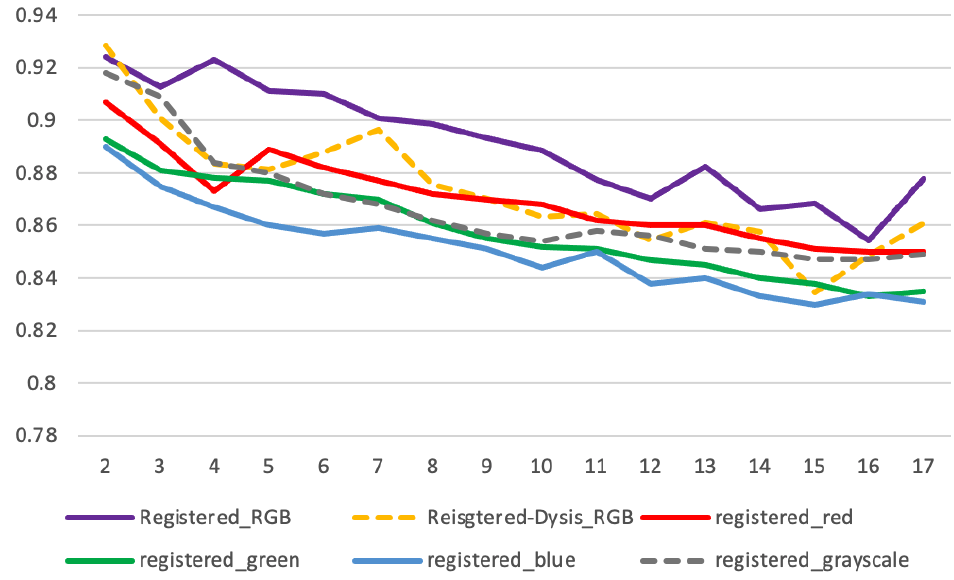
Figure 6. Dice ( y -axis) measurement between the 2nd, 3rd, . . . , 17th ( x -axis) image and the 1st fixed image in each sequence, using the registration algorithm by us (purple, legend: Registered_RGB) and by DYSIS (orange dash, legend: Registered-Dysis_RGB).